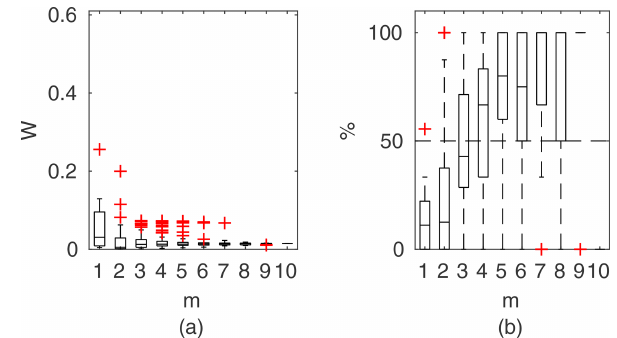
Figure B5. PTLM results for flume case 1: (a) averaged relative confidence widths W as a function of observation set size m used for model identification; (b) percentage of verification points en- closed by the confidence intervals (100% denotes all points within intervals, box spans over the 25% and 75% quantiles, the median is given with horizontal line, whiskers indicate the result extent, and cross marks are for extreme values).